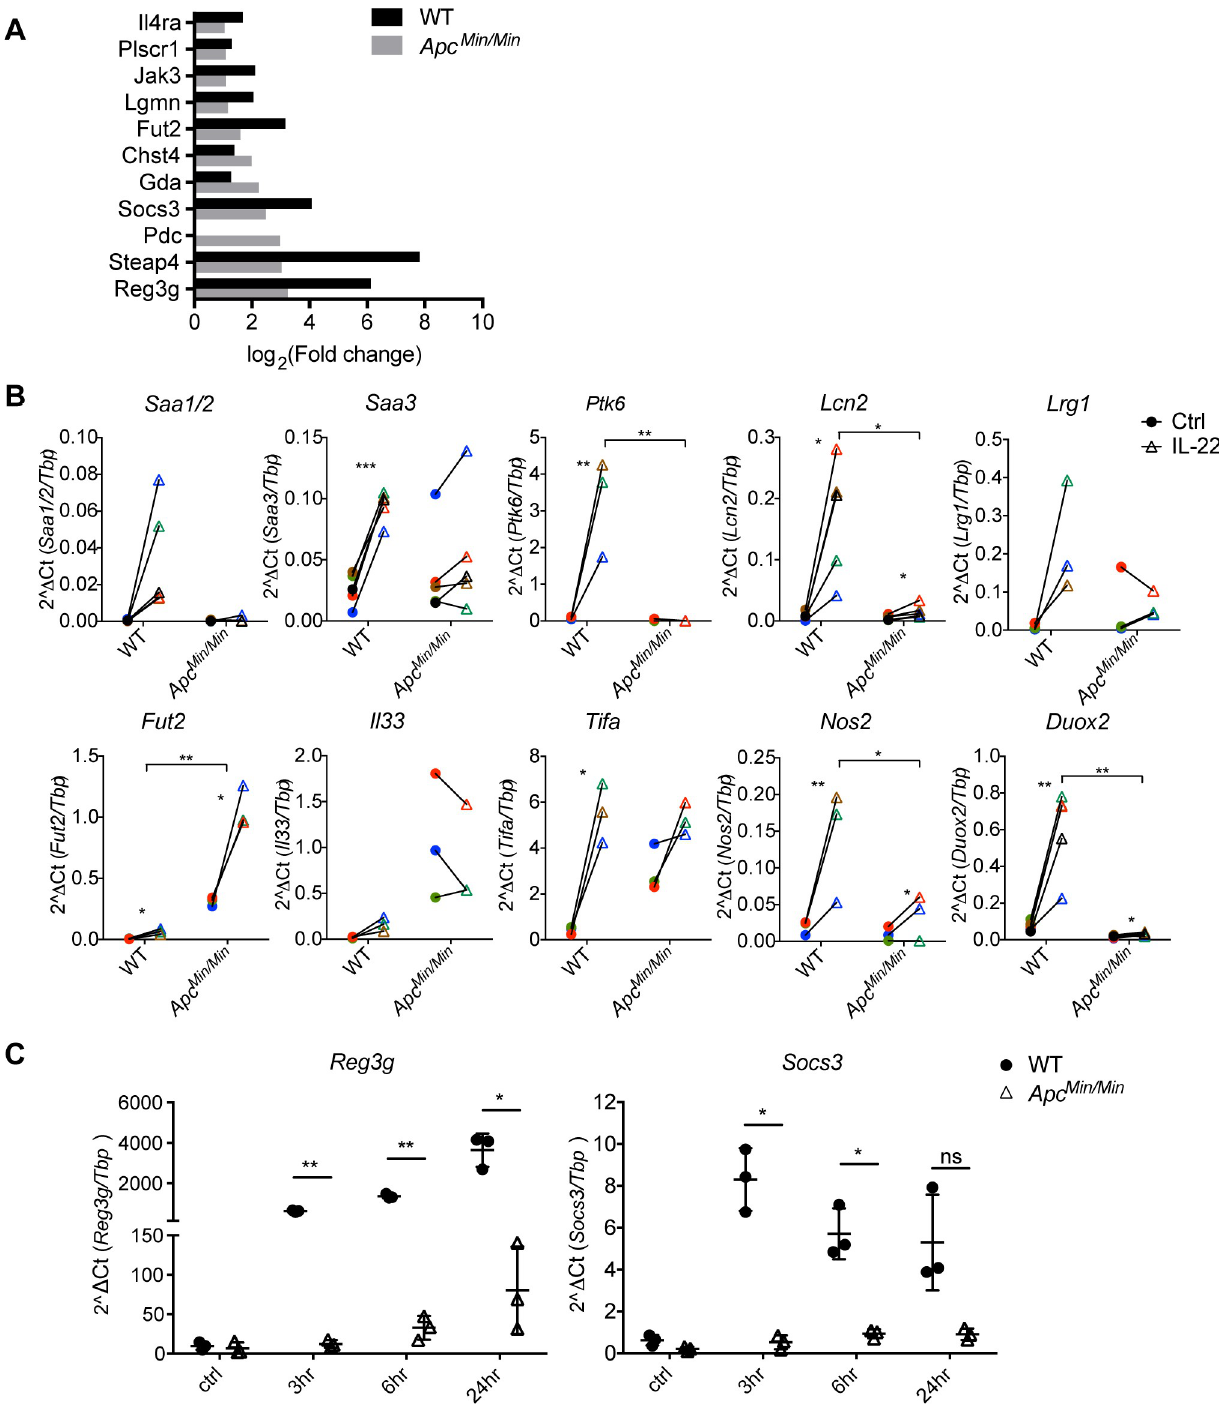
Fig 2. APC-mutant intestinal epithelial cells are defective in IL-22 mediated gene regulation. (A). WT and Apc Min/Min organoids were treated with IL- 22 (2 ng/ml) for 3 hours. RNA was isolated for RNAseq analysis. Graph shows the fold change of genes induced by IL-22 in WT and Apc Min/Min organoids. The 11 genes shown were the only genes up-regulated by IL-22 in Apc Min/Min organoids ( p < 0.1). (B) Expression of candidate up-regulated genes from RNAseq data were verified by RT-qPCR. Data shown are relative levels of mRNA for genes of interest relative to Tbp expression. At least 3 independent experiments were performed in each case. � p < 0.05, �� p < 0.01, ��� p < 0.001 on paired t test. (C). WT and Apc Min/Min organoids were treated with IL-22 (10 ng/ml) for 3, 6, or 24 hours, and RT-qPCR analysis was performed. Data show the relative expression of mRNA for Reg3g or Socs3 compared to Tbp . Three independent experiments were performed. � p < 0.05, �� p < 0.01, paired t test. Numerical values for (A), (B), and (C) are